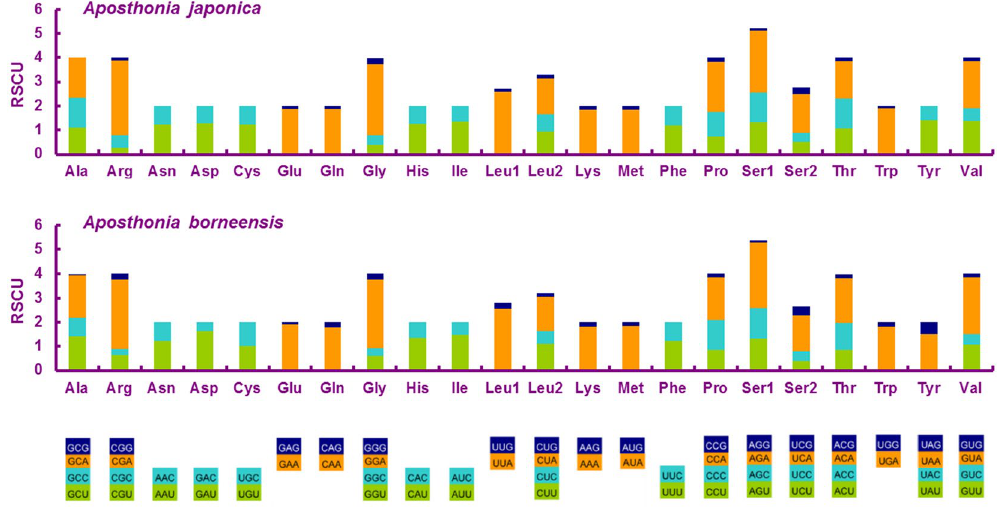
Figure 3. Relative synonymous codon usage (RSCU) in the two webspinner mitogenomes. Codon families are indicated below the X axis.